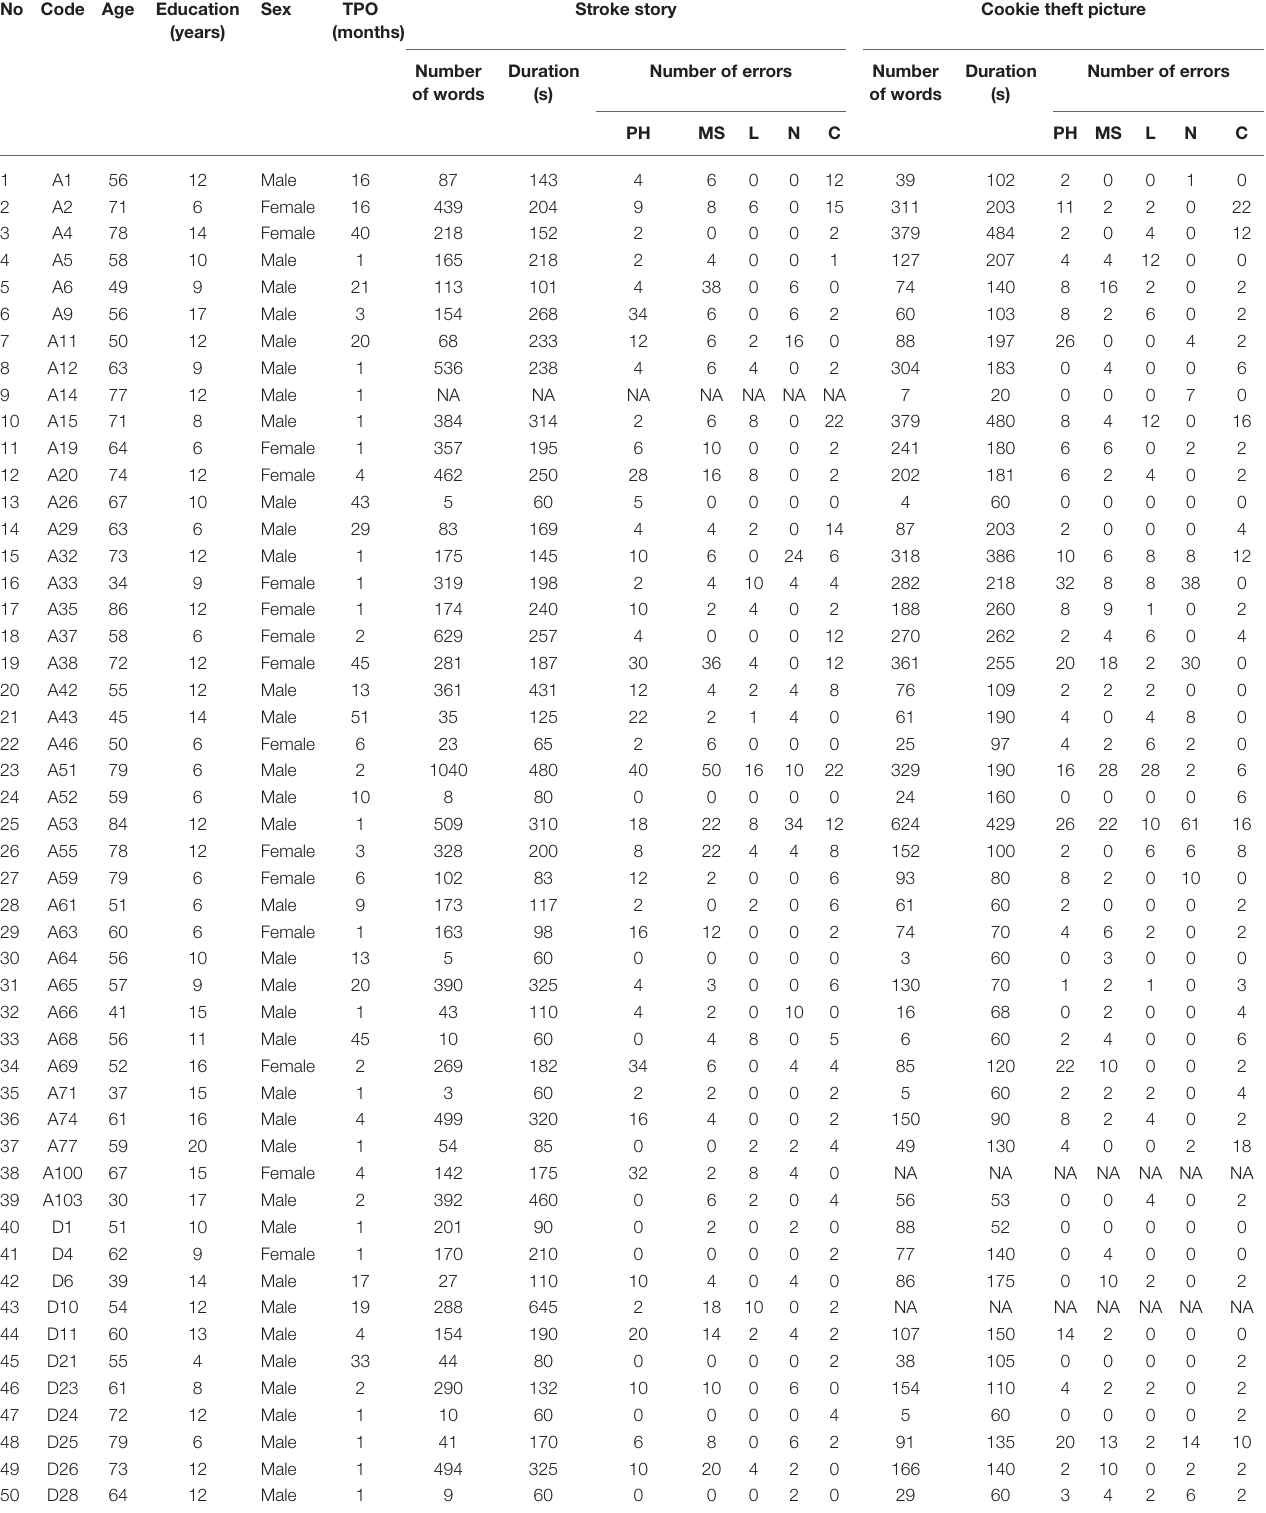
TABLE 1 | Demographic and sound files information for the patients with